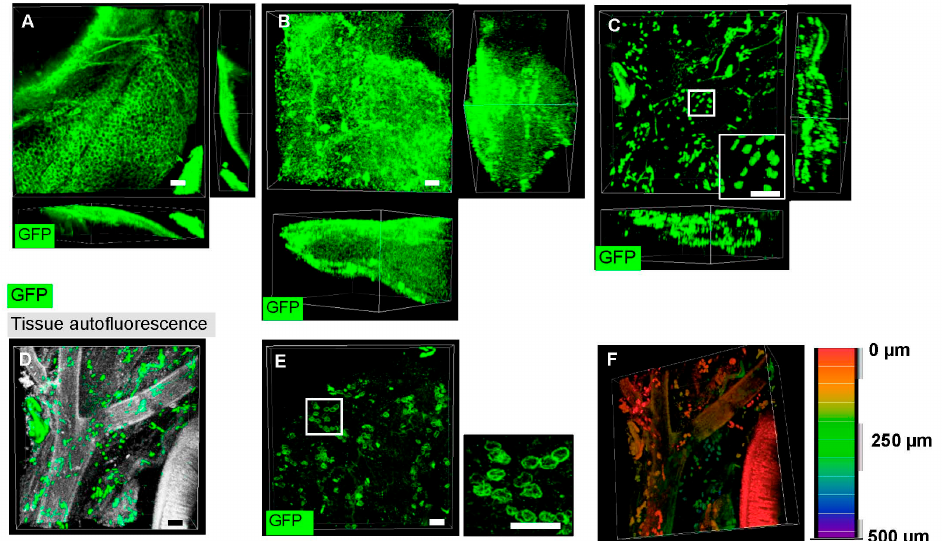
Figure 3. Development of optimized clearing protocol including BABB-D4 based clearing, DCM delipidation, and increased blocking improves staining of Type-1 adipocytes in mesenteric adipose tissue associated intestines of Wt1-cre ERT2 /ROSA2 6mTmG mice. Representative confocal images (and relevant orthogonal view of tissues) of BABB-D4-cleared tissue ( A ) without DCM delipidation and ( B ) with DCM delipidation; ( C ) Representative confocal image of tissue cleared with the final clearing protocol including DCM delipidation, BABB-D4-clearing tissue, and increased blocking. An enlarged image of GFP+ adipocytes are shown in the right bottom corner; ( D ) Image C with tissue autofluorescence (gray) to observe the positions of GFP+ adipocytes with respect to other tissue structures (e.g., intestines and blood vessels); ( E ) Representative confocal image of BABB-D4-cleared perigonadal tissues with more obvious and larger adipocytes; ( F ) Color-coded depth representation of image C, demonstrating the penetration of primary anti-GFP and secondary Alexa 647 conjugated antibodies throughout tissues. All pictures were taken at 100X magnification (10X objective). Scale bar = 100 µm, n =2 mice ~6 weeks of age.